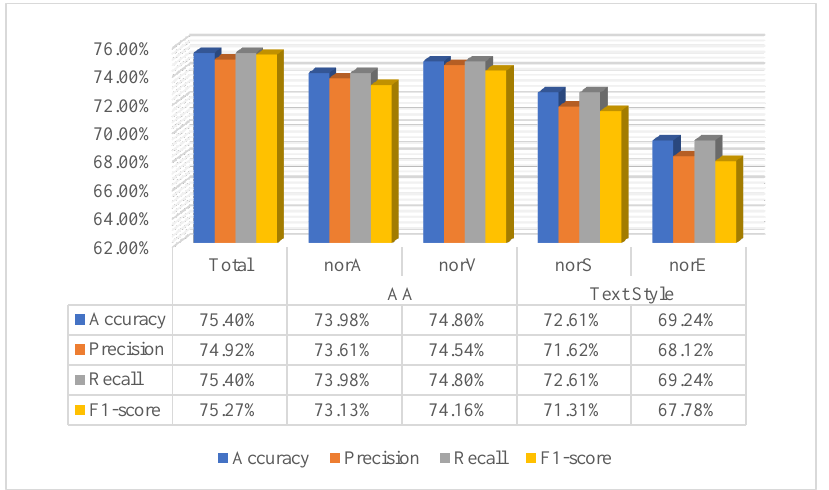
Figure 11. Effectiveness of different annotations.